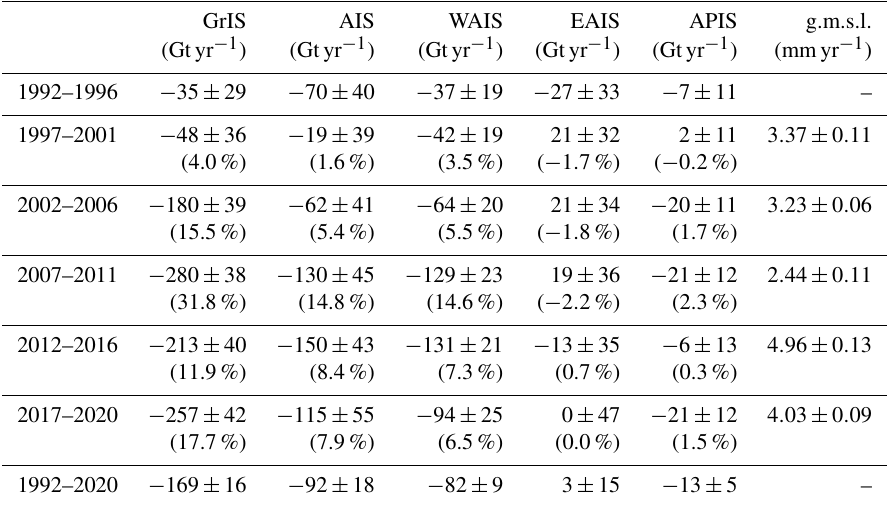
Table 2. Rates of ice sheet mass change (Gtyr − 1 ). Rates are calculated from the first day (1 January) of the first year quoted to the last day (31 December) of the final year quoted in the table. For context, the last column gives the g.m.s.l. trend (mmyr − 1 ), calculated from the Aviso product (https://www.aviso.altimetry.fr/msl/, last access: 12 April 2022) over the same period (as the g.m.s.l. record starts in 1993, we do not compute the fraction of sea level rise from the ice sheets for the first and last time period of the table). The percentage in parentheses is the fraction of the sea level rise driven by the ice